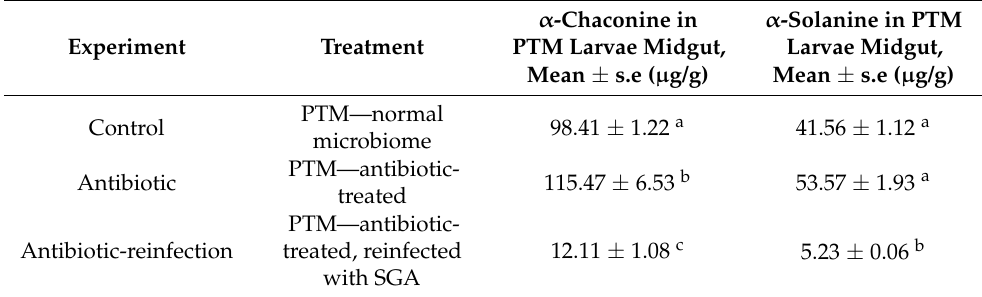
Table 4. Quantification using UHPLC–MS/MS of the role of bacteria in the transformation of SGA in PTM larvae.